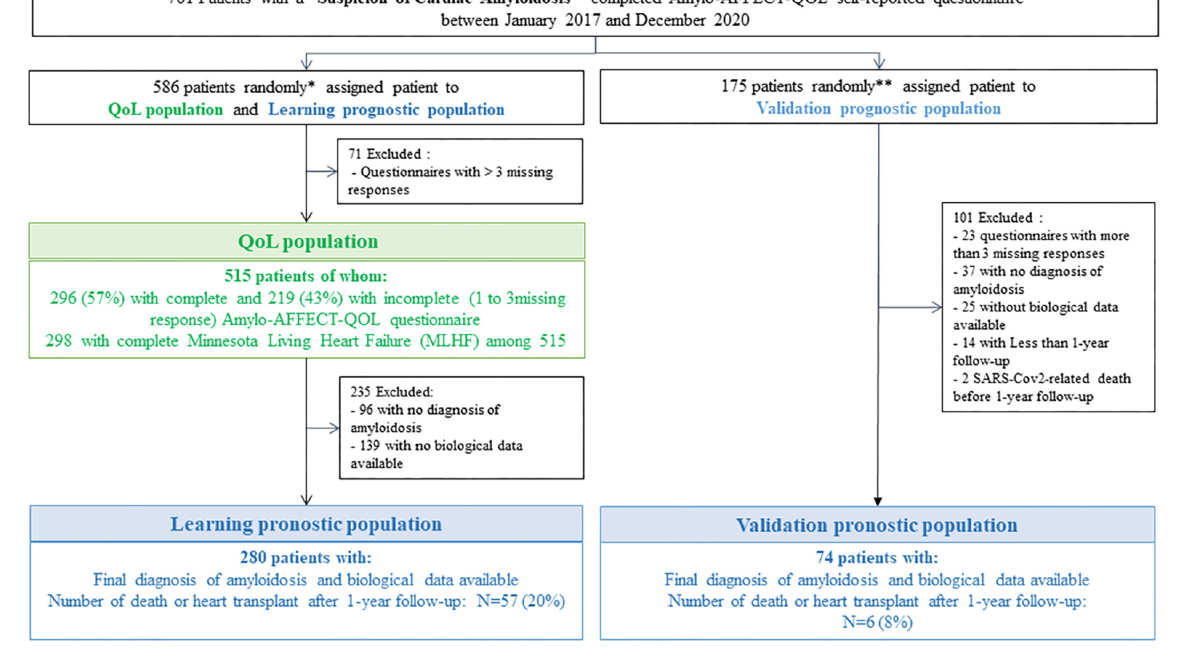
FIGURE1 Flowchart of study populations: QoL population and learning and validation population. ∗ Included all patients who completed Amylo-AFFECT questionnaire between January 2017 and January 2019 and a randomly sample of patients who completed Amylo-AFFECT questionnaire between January 2019 and December 2019. ∗∗ Included a randomly sample of patients who completed Amylo-AFFECT questionnaire between January 2019 and December 2019 and all patients who completed Amylo-AFFECT questionnaire between January 2020 and December 2020.